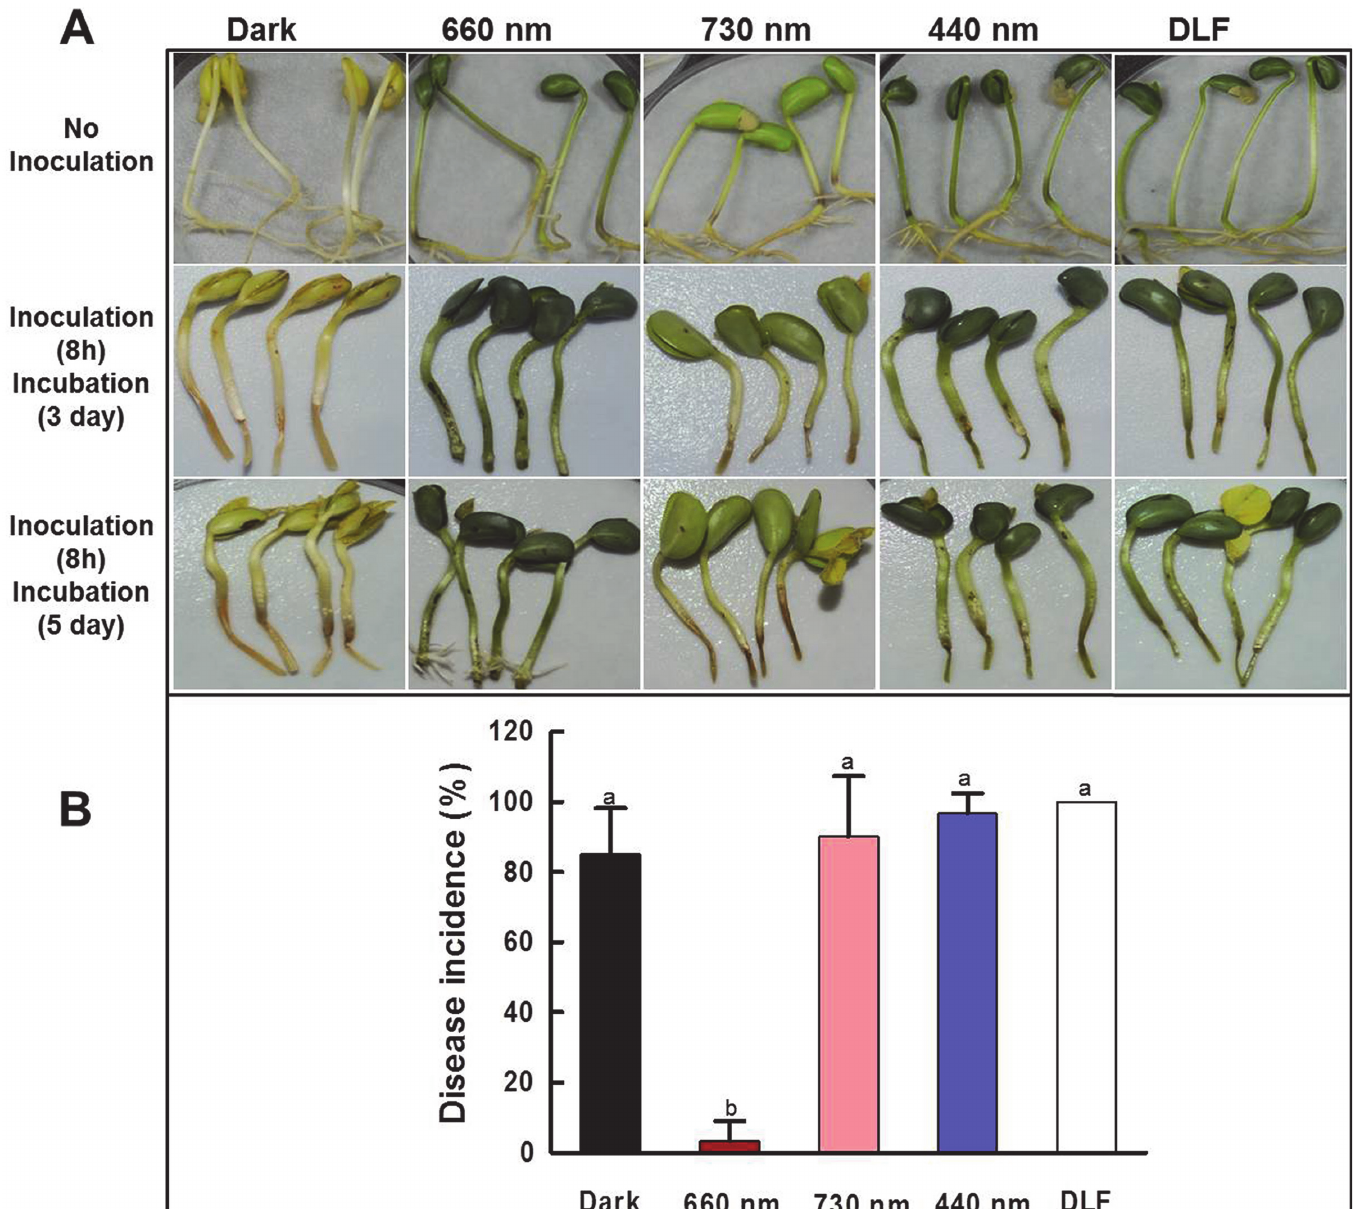
Fig 1. Effects of different wavelengths on the growth of soybean sprouts and disease susceptibility to Pseudomonas putida 229. Soybean sprouts were germinated for 5 days under different conditions. (A) The soybean sprouts germinated in darkness, red light, far-red light, blue light and fluorescence daylight. The sprouts tips were cut, inoculated in bacterial culture for 8 h, and then incubated for 5 days in darkness. The disease symptoms were observed after 3 and 5 days of incubation in darkness. (B) Comparison of disease incidence in soybean sprouts germinated in darkness and under different light irradiation for 5 days. The experiments were repeated four times. The different letter indicates a significant difference ( P < 0.01). doi:10.1371/journal.pone.0117712.g001 white light were dark green, while those germinated under far-red light were light green (Fig. 1A). The sprouts germinated in darkness had yellow seeds and white hypocotyls due to the lack of chlorophylls in the absence of photosynthesis. Additionally, the sprouts germinated under far-red light had shorter hypocotyls than those grown under other conditions (Fig. 1A).